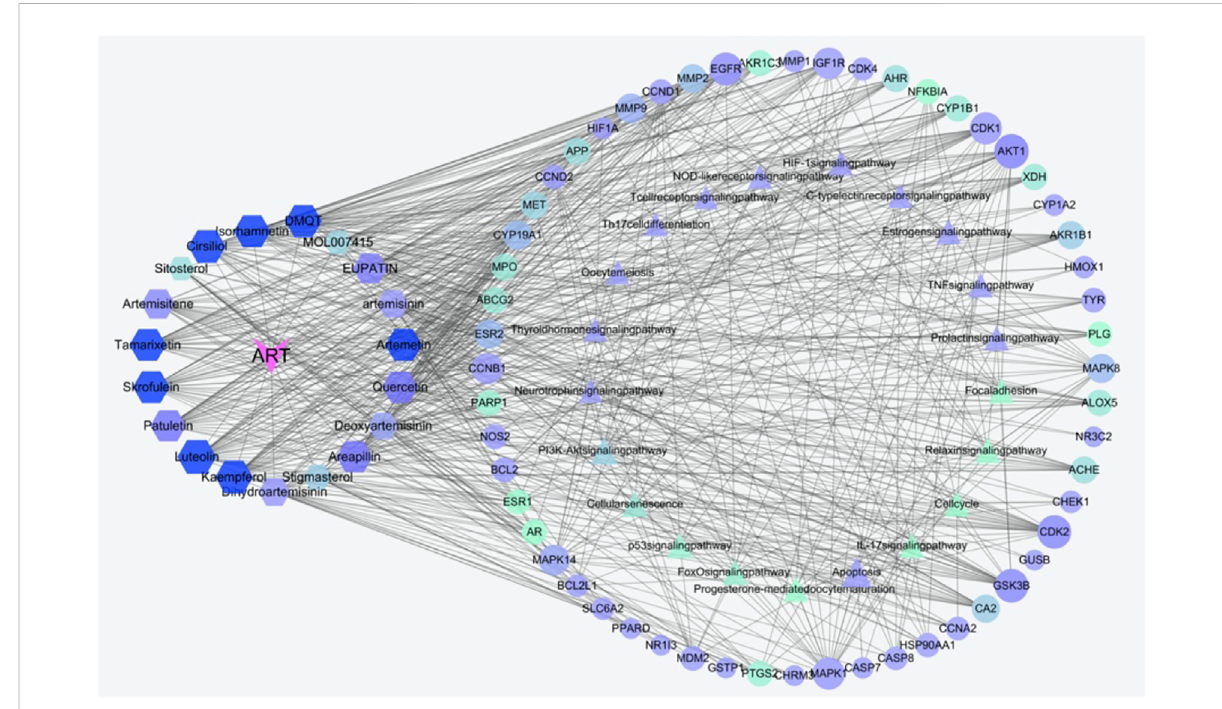
FIGURE 4 Construction of the compounds-targets-pathways network. The pink V ’ s represent artemisinin; the hexagons indicate active compounds, the triangularnodesrepresentKEGGpathways,theellipticalnodesindicateintersectedtargets.Linesinthe fi gurerepresenttheinteractionbetweentwo nodes. Both node size and color are in ascending order according to degree.